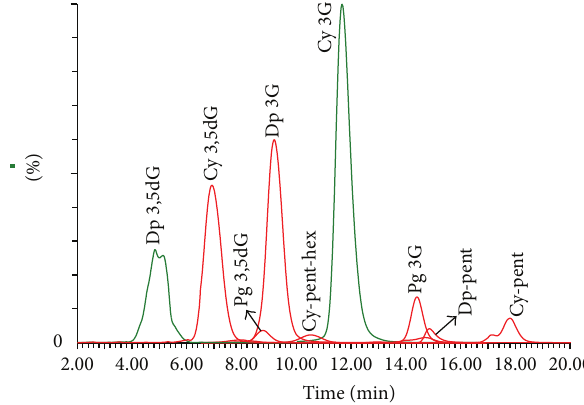
Figure 2: Typical chromatogram of the anthocyanidins in pomegranate juice (MYA) as detected by MS in SRM